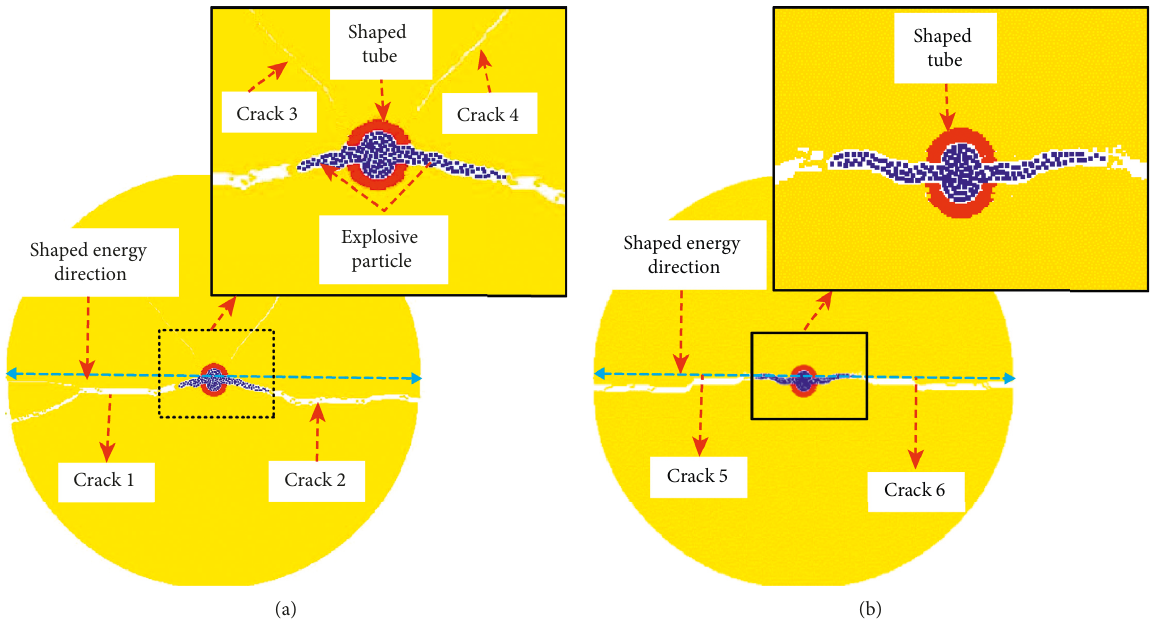
Figure 6: Particle motion process after detonation. (a) Conventional SPH method. (b) Automatic adaptive optimization